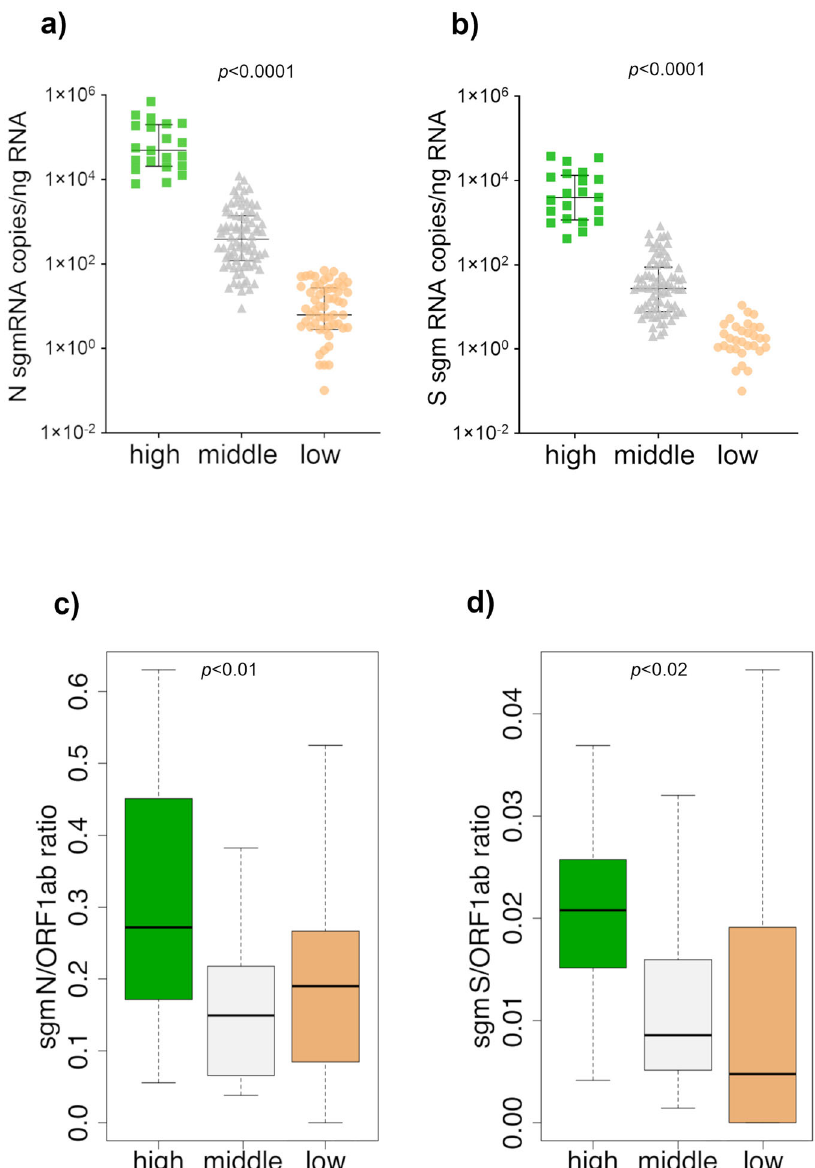
Fig. 2 SARS-CoV-2 N and S sub-genomic RNAs absolute quanti fi cation and their relative expression to genomic RNA in SARS-CoV-2 positive samples by ddPCR. N sgmRNA ( a ) and S sgmRNA ( b ) copies quanti fi cation in 166 RNA samples from SARS-CoV2 positive subjects. Based on ORF1ab gRNA and N and S sgmRNAs quanti fi cation, RNA samples were divided into three groups de fi ned as “ high ” ( n = 21, represented by the green square symbol), “ middle ” ( n = 82, represented by the gray triangle symbol) and “ low ” ( n = 63, represented by the orange circle symbol) viral RNA content. Values, reported in copies/ng RNA, are expressed as the means of a duplicate assay for each sample. Samples with zero sgmRNAs copies/ng RNA were not plotted in the graphs because logarithmic axes mathematically do not contemplate 0 value. Black lines represent median with relative interquartile range (IQR); p -value < 0.0001 calculated by Kruskal − Wallis test. N sgmRNA ( c ) and S sgmRNA ( d ) expression were evaluated as ratio respect to ORF1ab gRNA in “ high ” (green), “ middle ” (gray), and “ low ” (orange) viral RNA content group. Values are reported as sgmRNA/ORF1ab RNA copies/ng RNA. Signi fi cance was evaluated comparing “ high ” group vs “ middle ” and “ low ” groups by Mann – Whitney U test /Wilcoxon rank-sum. Data are presented as median with relative interquartile range (IQR). For N sgmRNA: p -value = 0.01075 for “ low ” and 0.001314 for “ middle ” ; for S sgmRNA: p -value = 0.002126 for “ low ” and 0.0001246 for “ middle ”